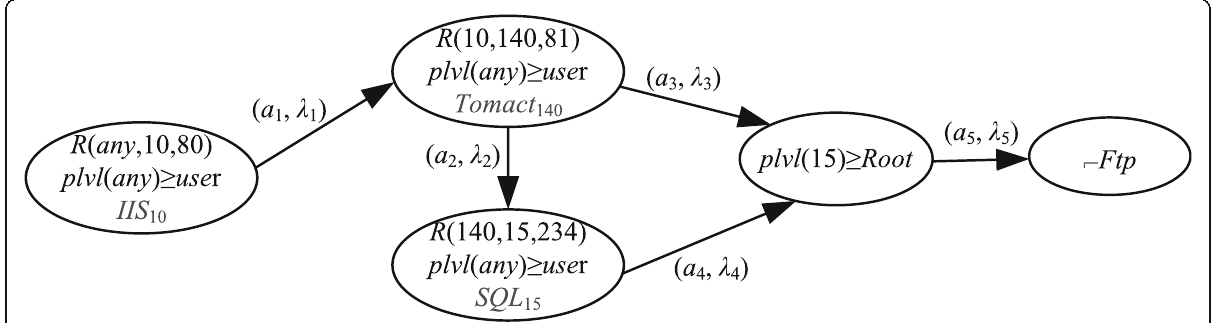
Fig. 6 Modeling results of reliability quantitative model of experimental